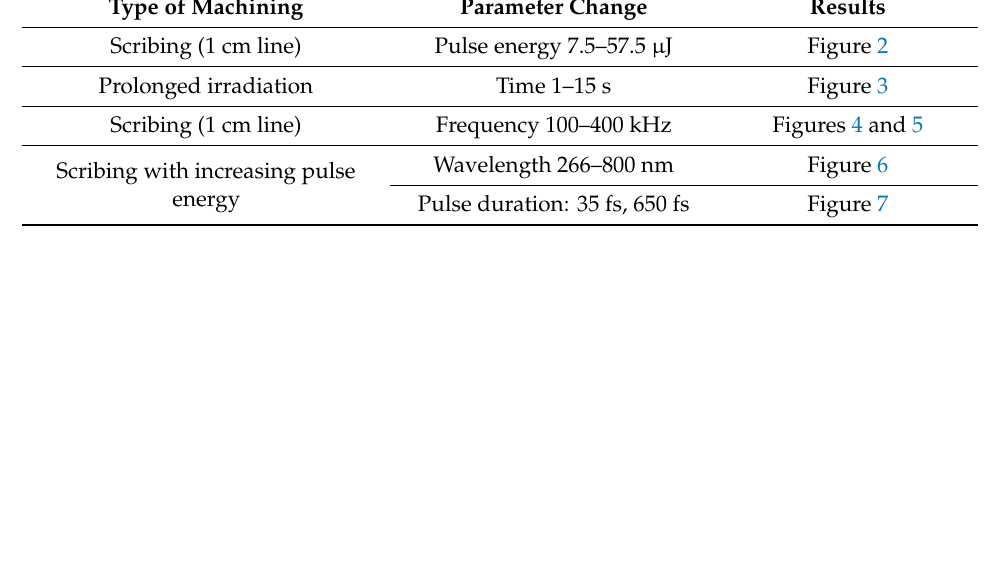
Figure 4. Aluminum sample scribed with sub-picosecond Yb:KYW laser (650 fs, 1030 nm).